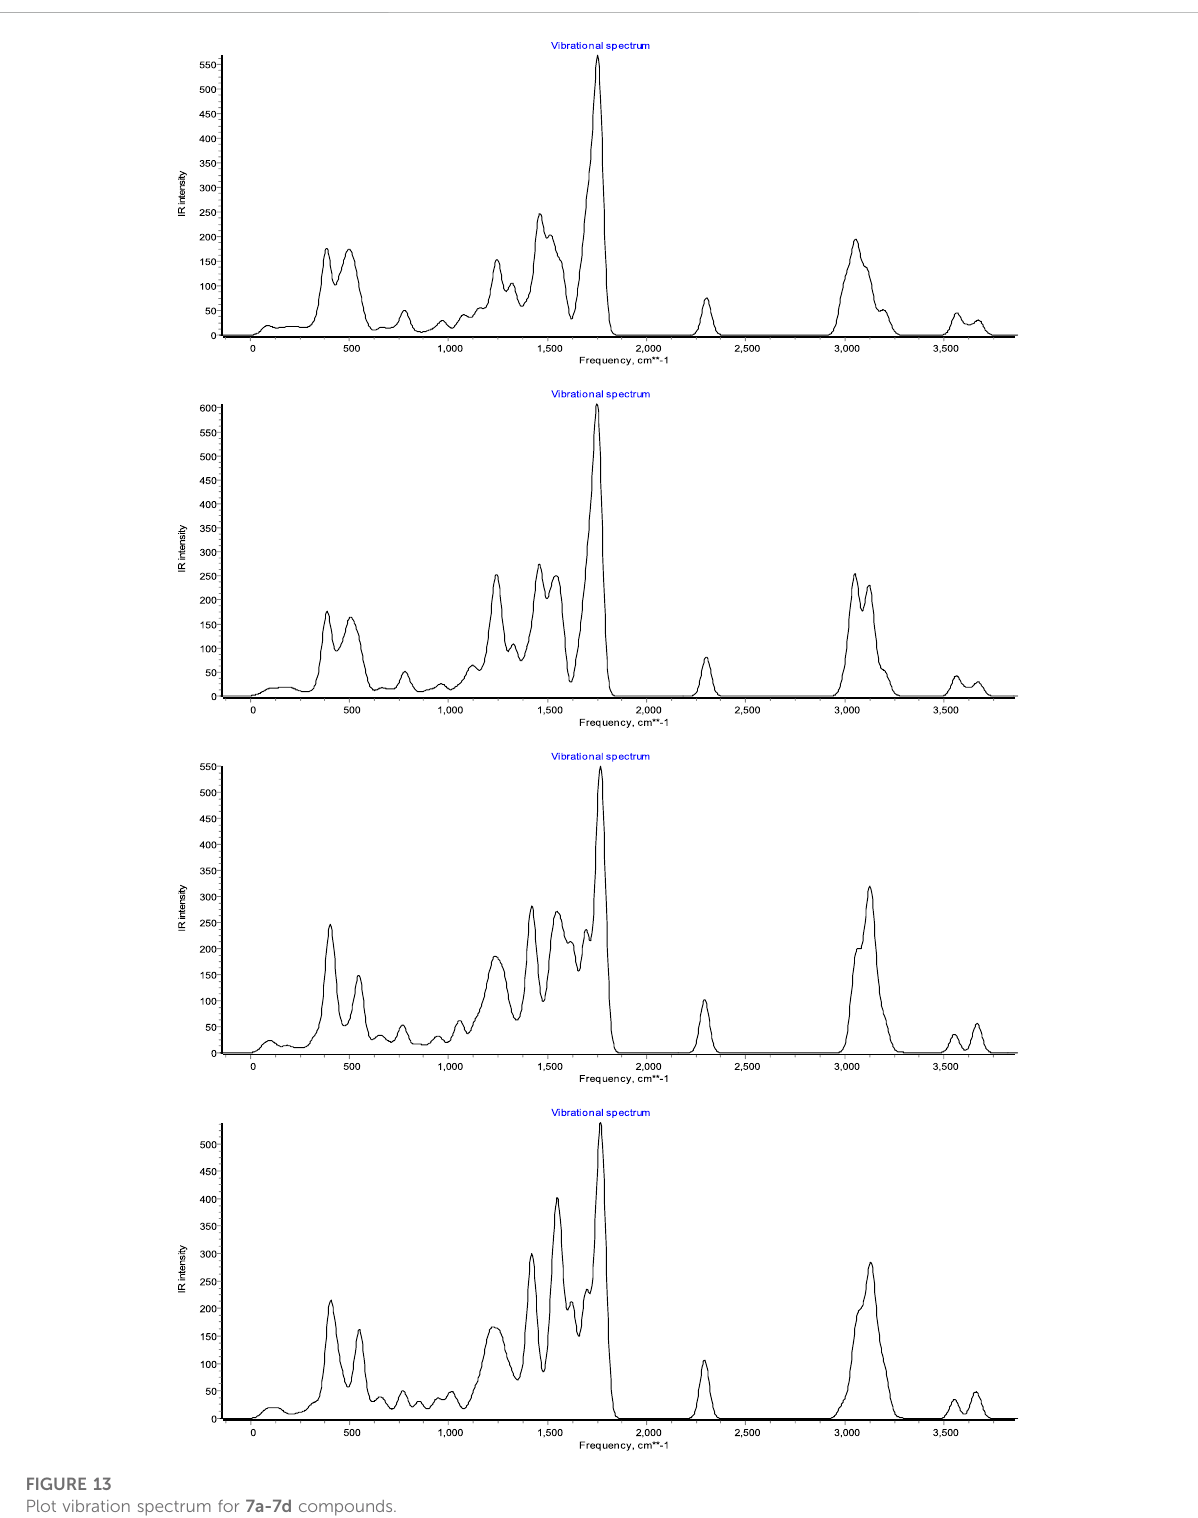
FIGURE 13 Plot vibration spectrum for 7a-7d